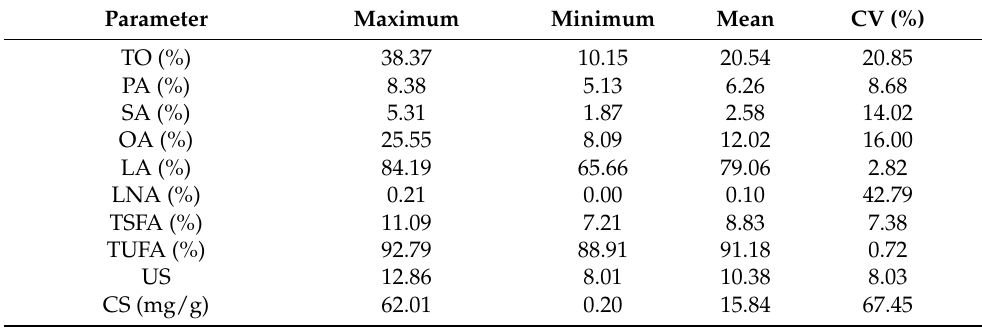
Table 1. Summary statistics of total oil content, fatty acid profile, phytochemical contents, and antioxidant activities of 197 safflower accessions’